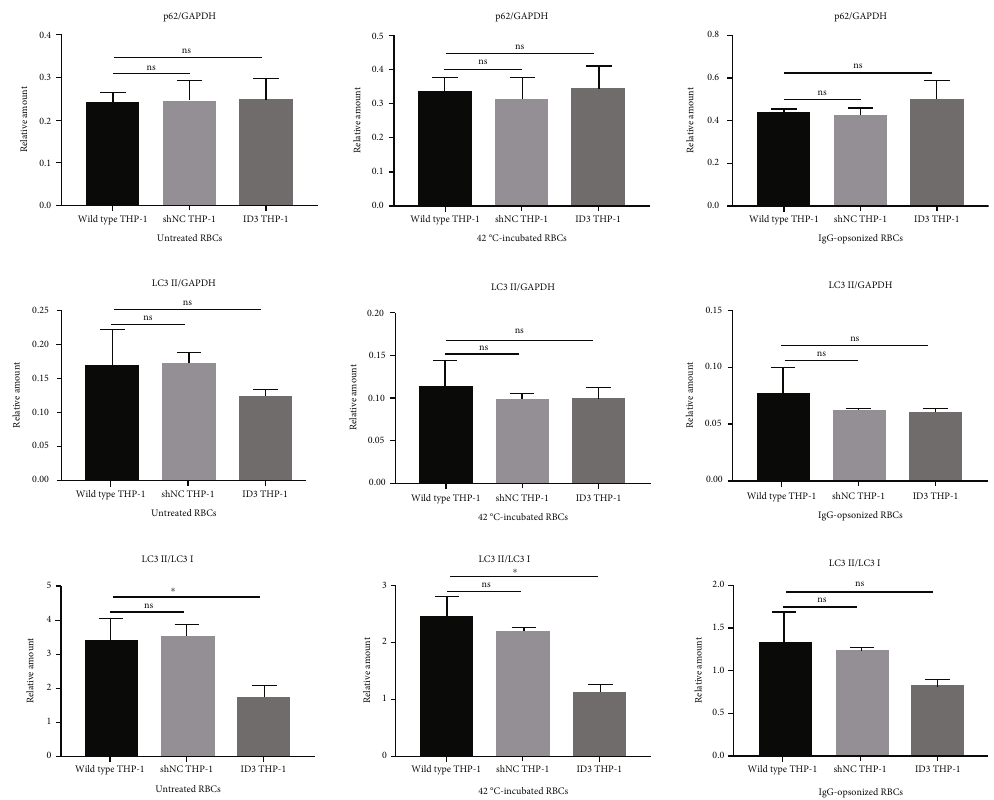
Figure 5: Autophagy of THP-1 caused by engul fi ng RBCs is inhibited by the downregulated expression of NLRP3. Three relative amounts (p62 vs. GAPDH, LC3 II vs. GAPDH, and LC3 II vs. LC3 I) were calculated according to gray values obtained in Figure 6(a). These data focus on the autophagy of wild type, shNC, and ID3 THP-1 cells after phagocytosis of the same RBCs without bafromycin. ID3 THP-1 cells showed the minimum autophagy marker regardless of the kind of RBCs they were incubated with. ∗ p < 0 : 05 , ∗∗ p < 0 : 01 , and ns: not signi fi